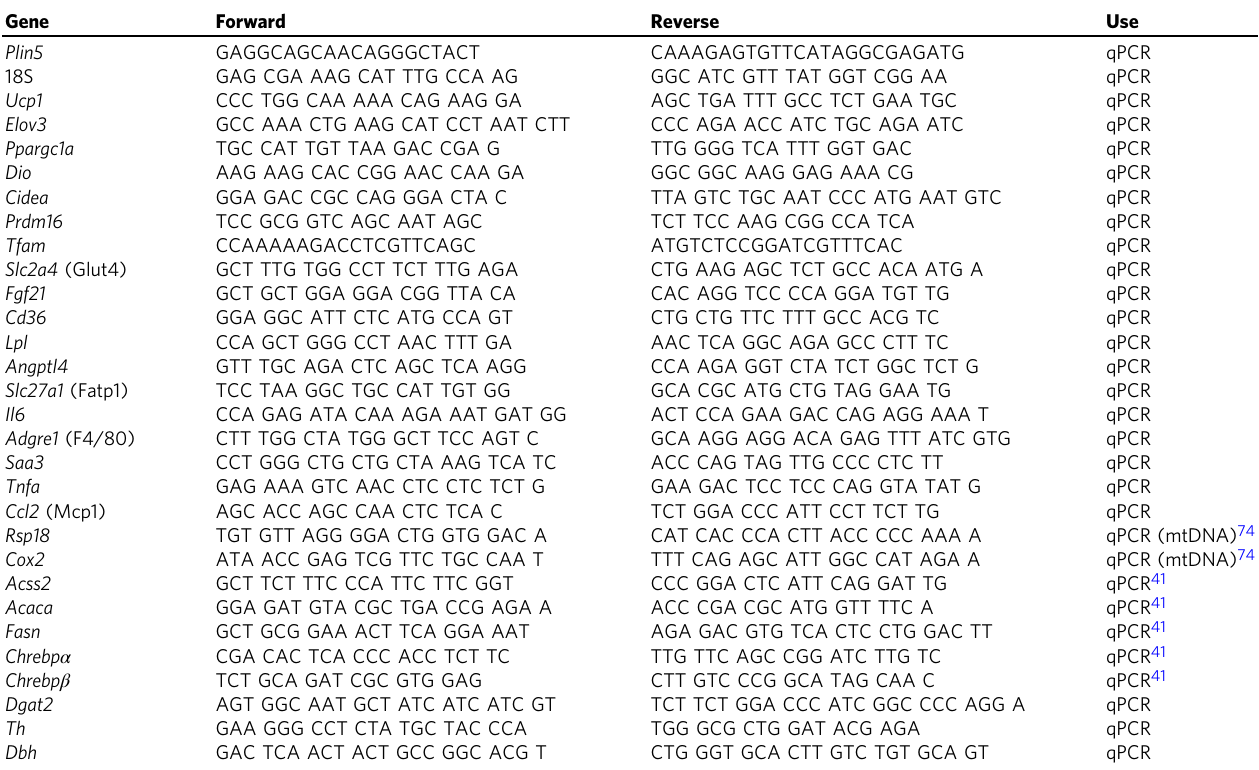
Table 2 Primer sequences.